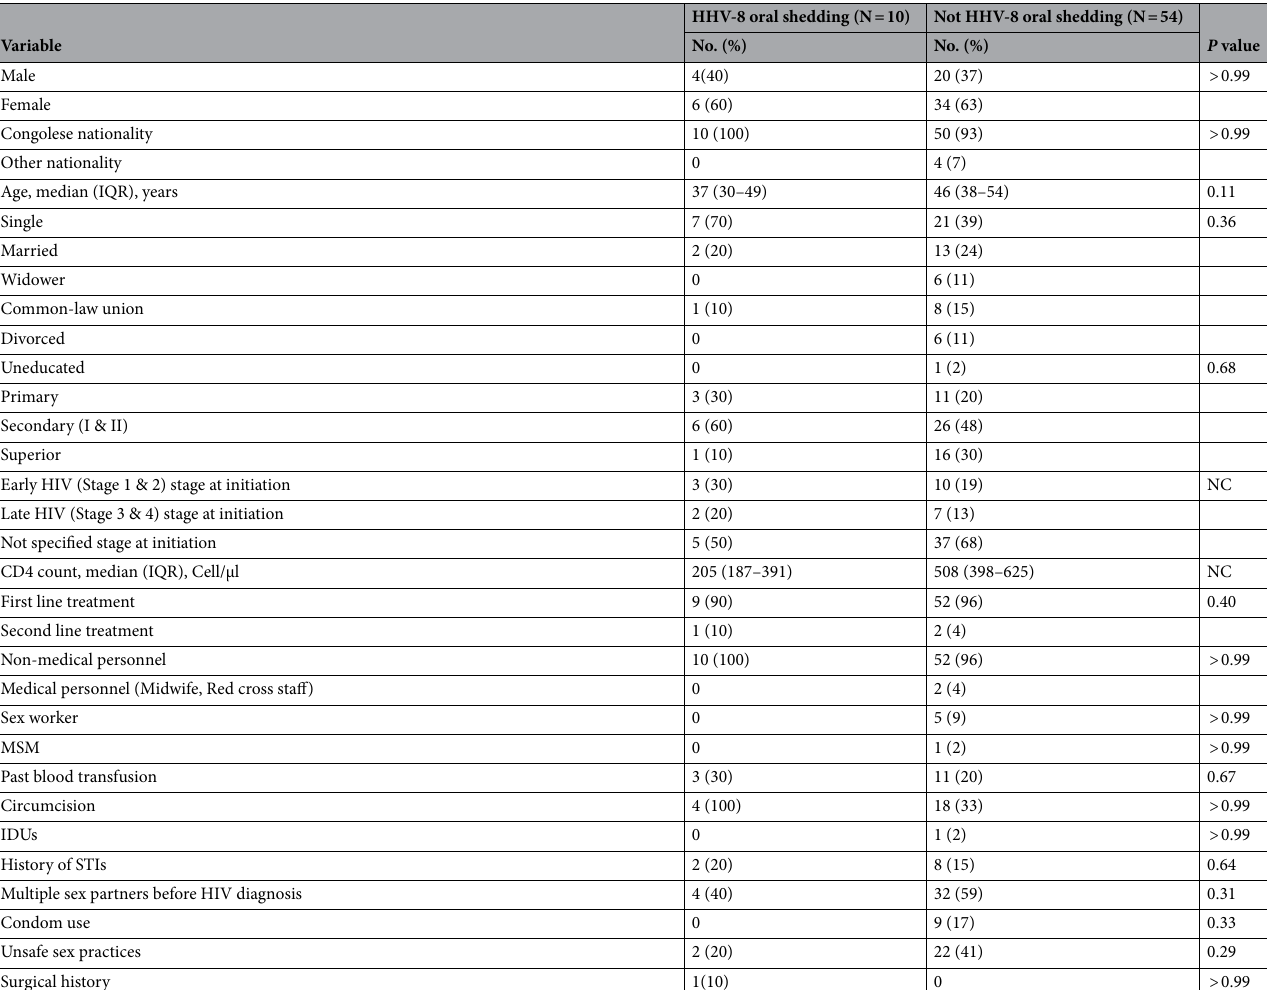
Table 3. Comparison between HHV-8 oral shedders and non-oral shedders. HIV: human immunodeficiency virus; IDUs: intravenous drug users; IQR: interquartile; MSM: men who have sex with men; NC: non calculated; STI: sexually transmitted